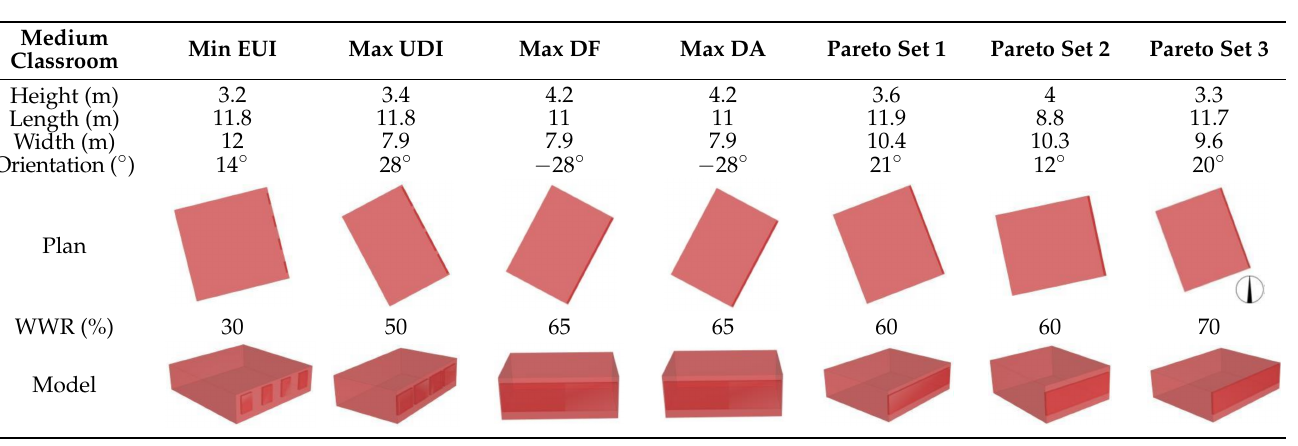
Table 14. Genomes in detail and phenotype output for medium-sized classrooms with east facade